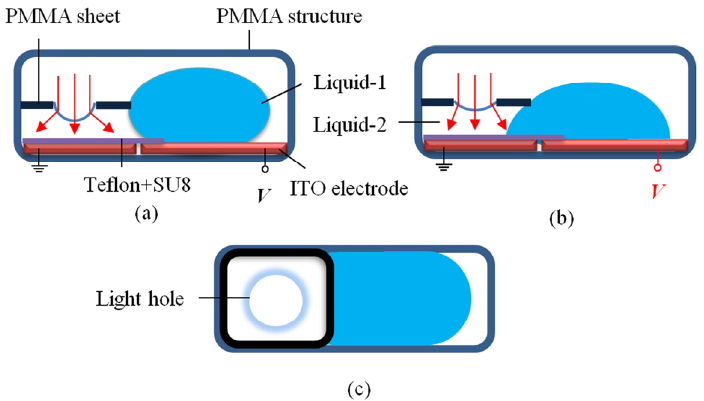
Figure 1. Schematic of the proposed device and the operation mechanism: ( a ) Initial state; ( b ) Applied voltage to the device; ( c ) Top view of the